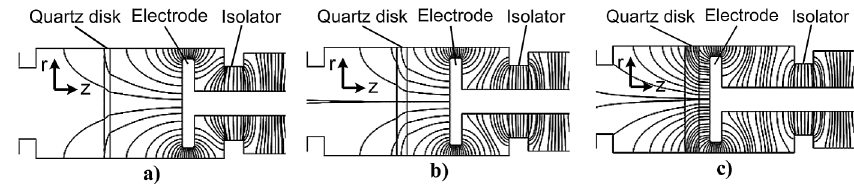
FIG. 4. Distribution of the electrostatic field lines inside the resonator for quartz disks having different thicknesses: